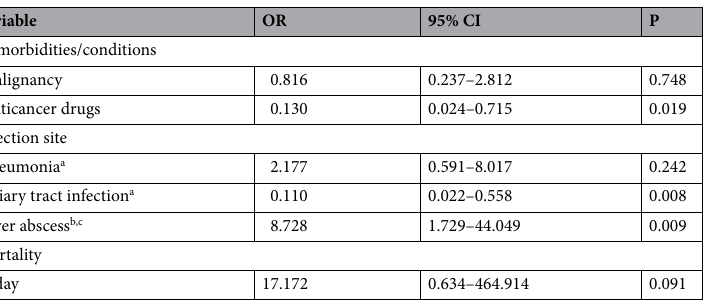
Table 5. Correlation between rmpA -positive isolates and clinical factors in K. pneumoniae bloodstream infections. OR, odds ratio; CI, confidence interval. a Clinical diagnosis with K. pneumoniae isolation from each site. b Clinical diagnosis regardless of K. pneumoniae isolation from each site. c Infectious hepatic cysts in two patients were